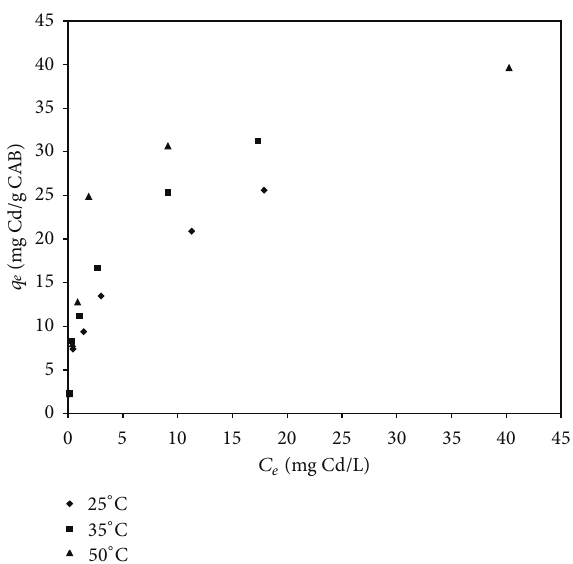
Figure 7: Isotherms of lead biosorption by CAB at 25 ∘ C, 35 ∘ C, and 50 ∘